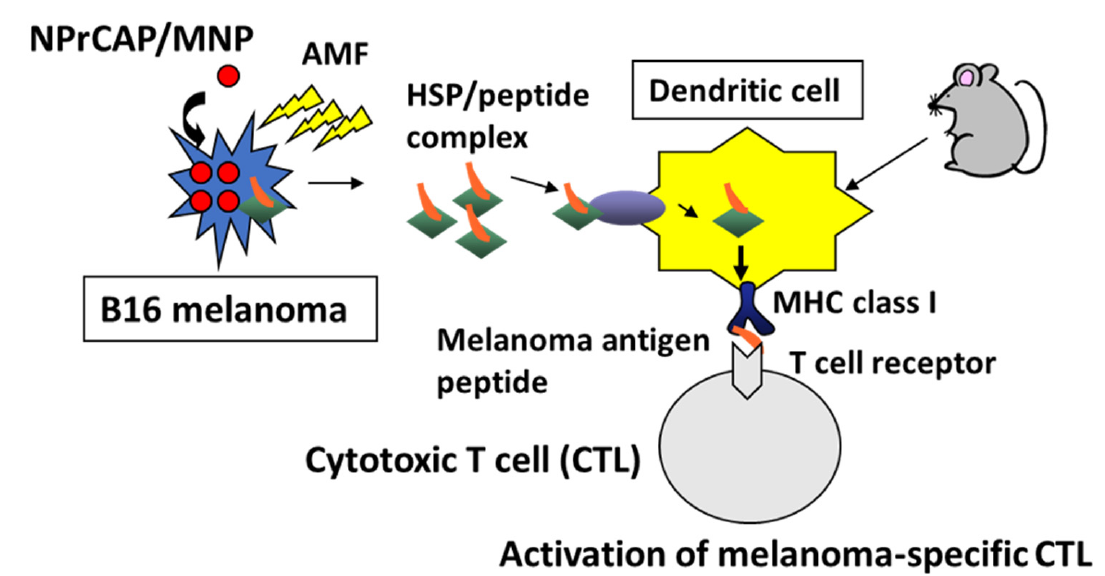
Figure 16. Induction of cytotoxic T cells specific for melanoma-associated antigen peptide by intracellular hyperthermia generated by NPrCAP with AMF. (1) Treatment of melanoma using NPrCAP/MNP with AMF induces various types of HSPs that bind melanoma-associated antigen peptides, and necrotic melanoma cells release HSP-antigen peptide complexes in the tumor micro- environment. (2) Infiltrated dendritic cells (DCs), which sense the inflammation induced by hyper- thermia, take up HSP-peptide complexes and cross-present HSP-chaperoned antigen peptides to antigen specific cytotoxic T lymphocytes (CTLs).